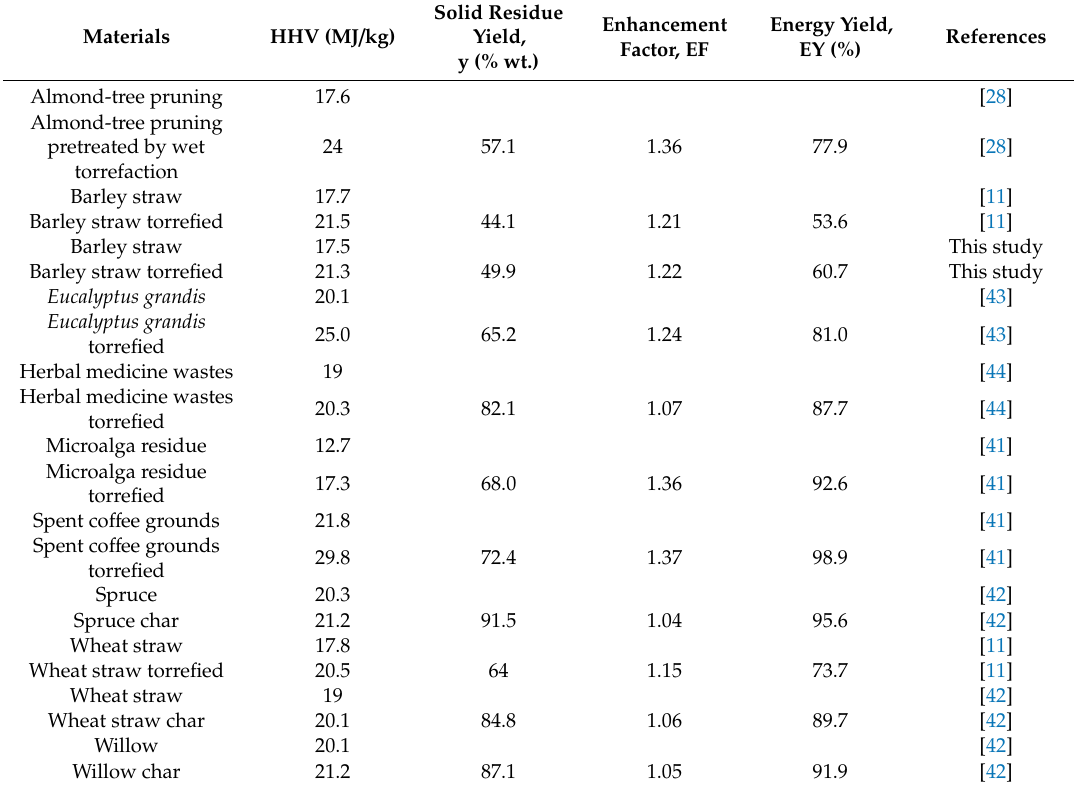
Table 5. Higher Heating Value of combustion, Solid residue yield, Enhancement factor and Energy yield for some untreated and torrefied lignocellulosic